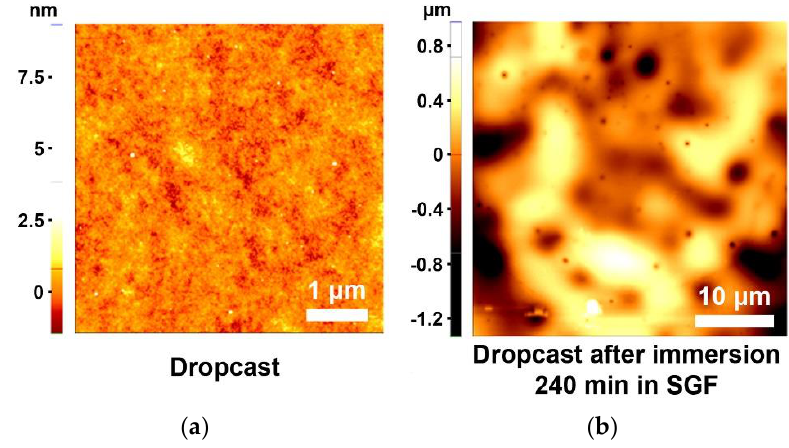
Figure 9. AFM image on 5 × 5 µm 2 on a dropcast film ( a ); AFM image on 40 × 40 µm 2 after 240 min immersion in SGF ( b ).